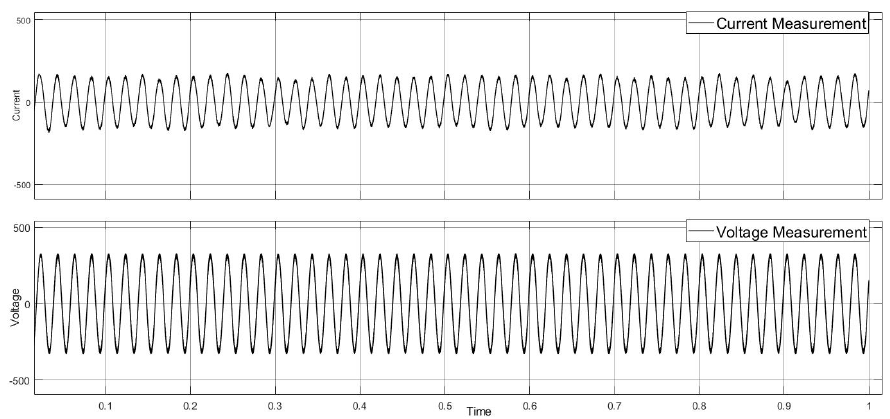
Figure 6. EV charging station rectifier input current and voltage signals .